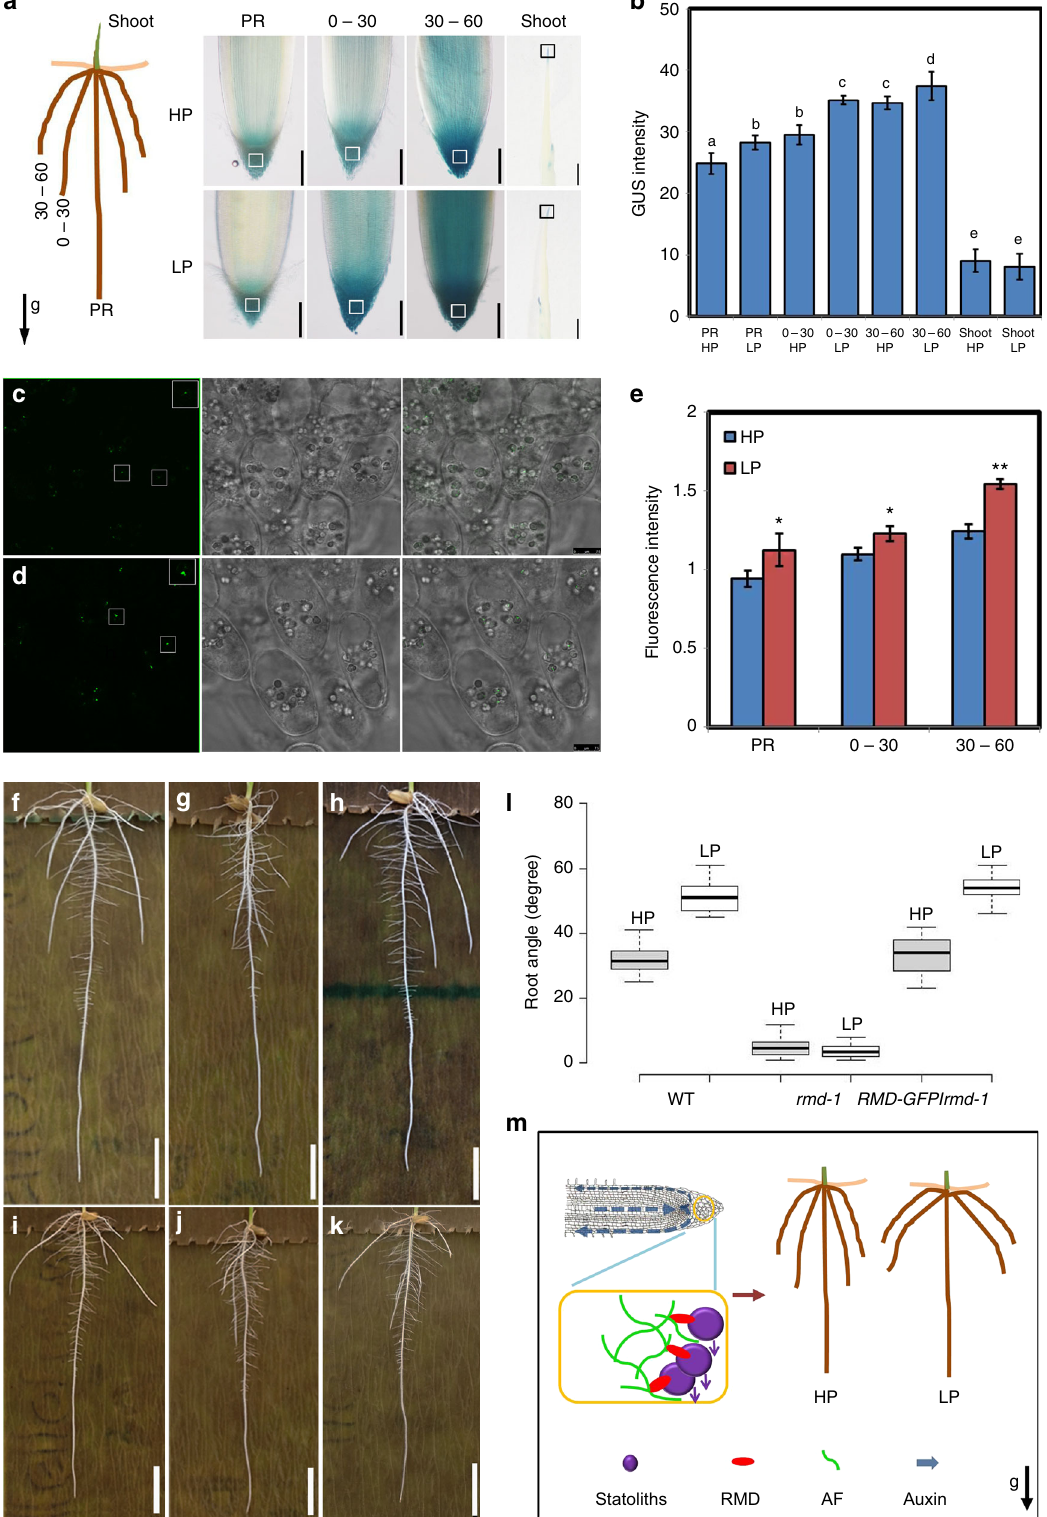
DR5::3XVENUS-N7 in WT columella cells under LP versus HP, while phosphate-starvation makers Phosphate Transporter